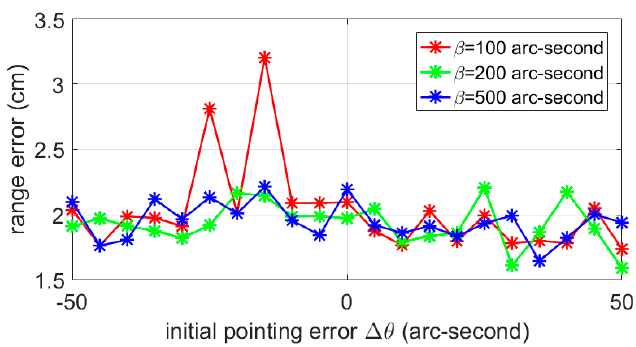
Figure 11. The result of range error calibration with an initial error of 50 cm.